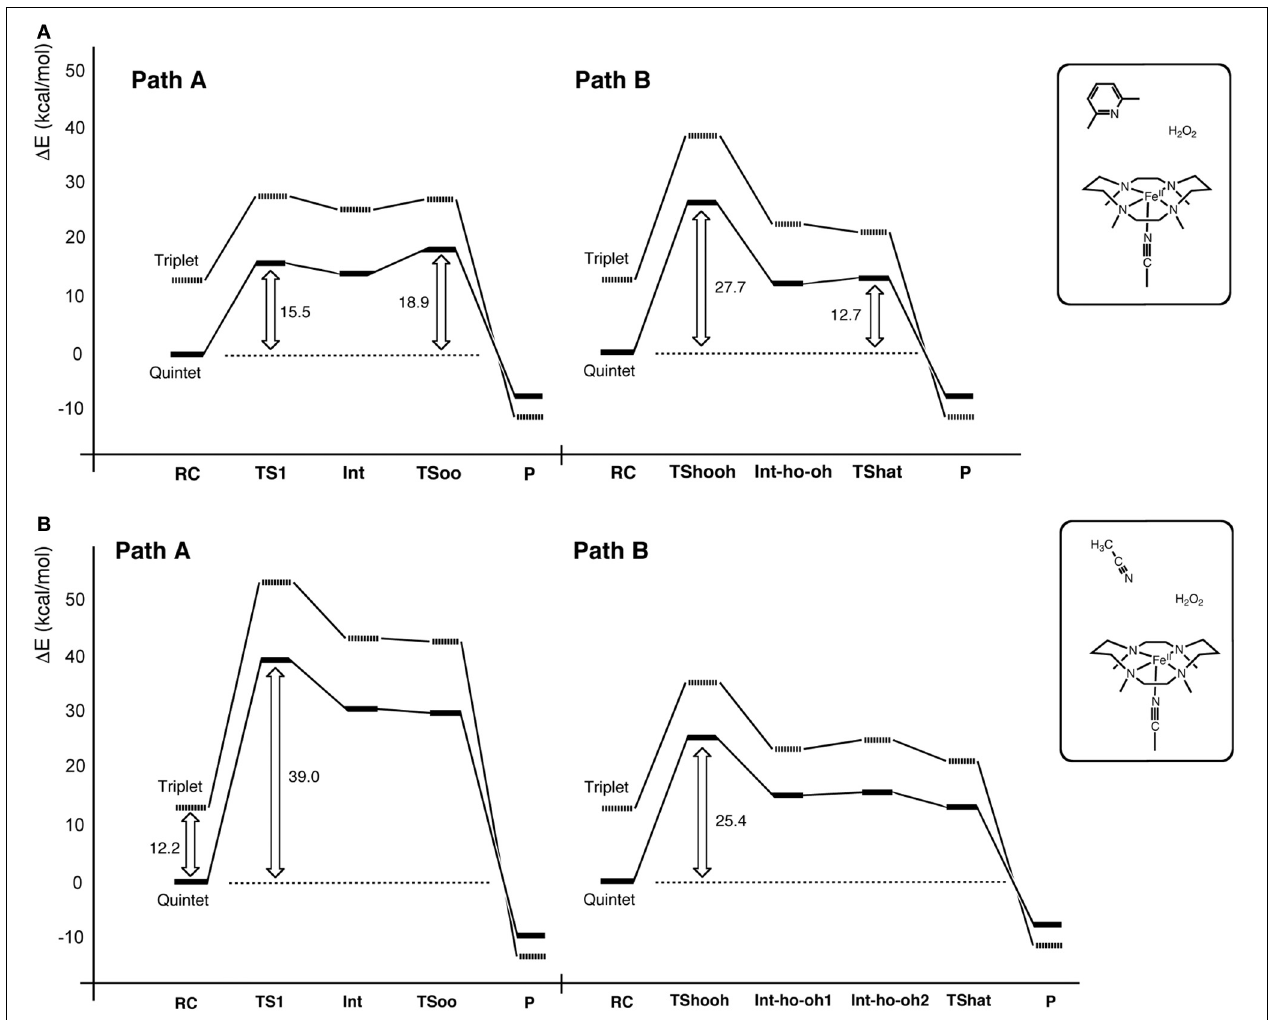
FIGURE 2 | Energy profiles for the reactions in Scheme 2C in the presence (A) and absence (B) of 2,6-lutidine. Adapted from Hirao et al. (2011) with permission from the American Chemical Society.